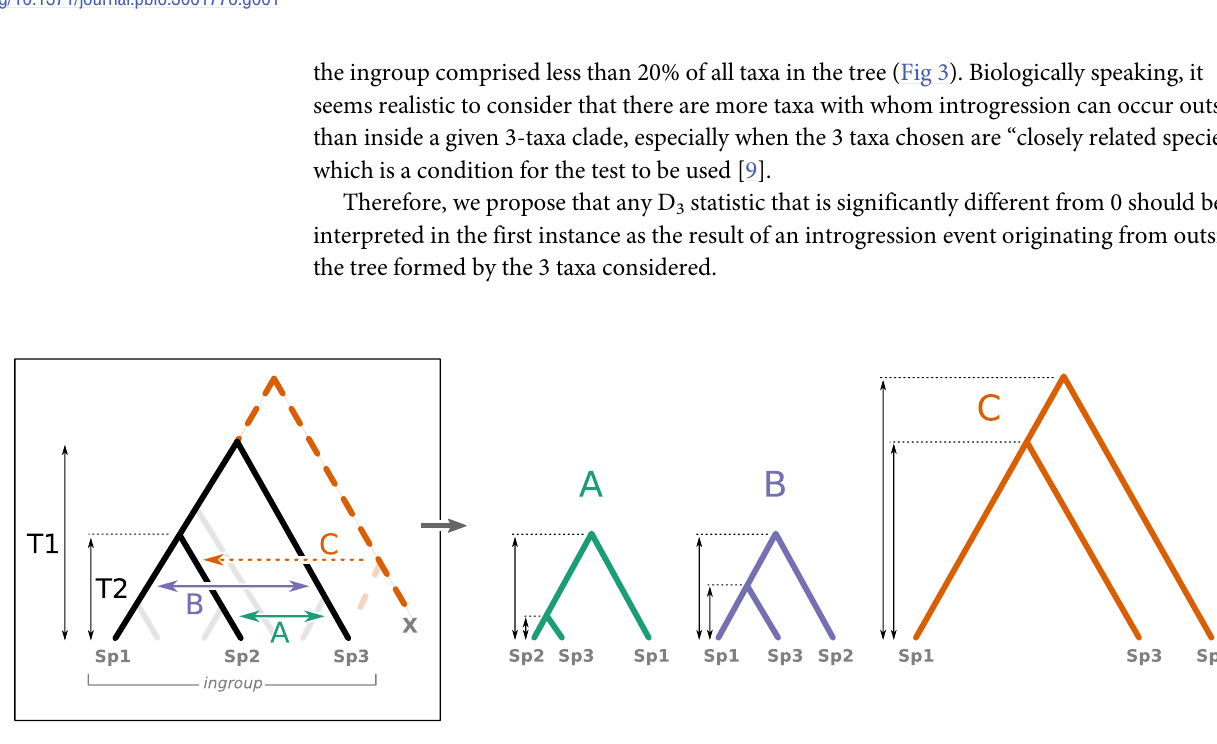
Fig 2. Effect of ghost lineages on a 3-taxon set (sp1, sp2, sp3) as used for the D3 test of introgression. Introgression from a ghost lineage (X) from outside the ingroup of interest produces a phylogenetic tree with increased branch lengths compared to the species tree (scenario C), while branch lengths are shorter when introgression occurs within the ingroup (scenarios A and B). The new branch-lengths pattern produced by the ghost lineage (X) drastically changes the interpretation of the D3 statistical test (see